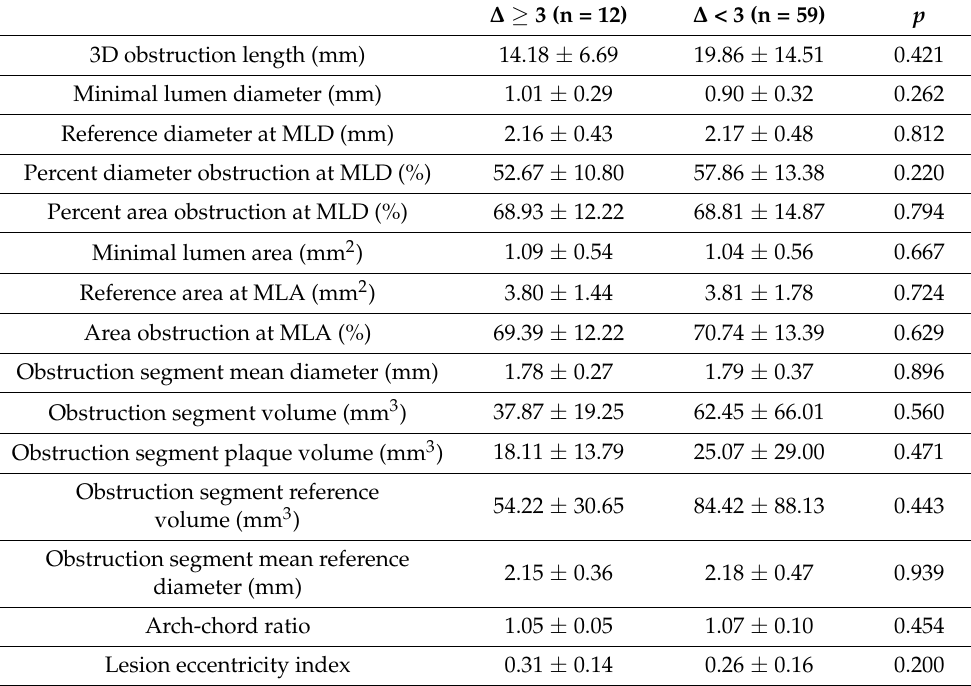
Table 5. 2/3D parameters in STEMI patients comparing TFC changes between ∆ ≥ 3 and ∆ < 3